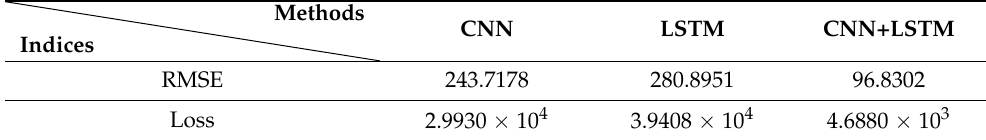
Table 5. Comparison of the training effectiveness of the three models after the first 300